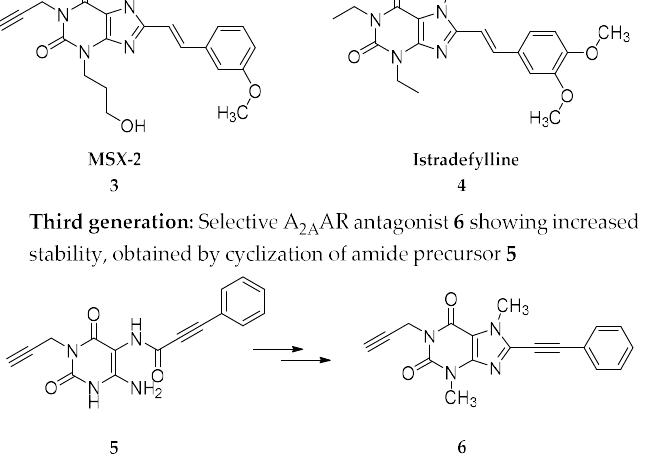
Figure 1. Examples of adenosine receptor antagonists with a xanthine scaffold. Shown is the development of the xanthine derivatives caffeine and theophylline towards potent and selective adenosine A 2A receptor antagonists.